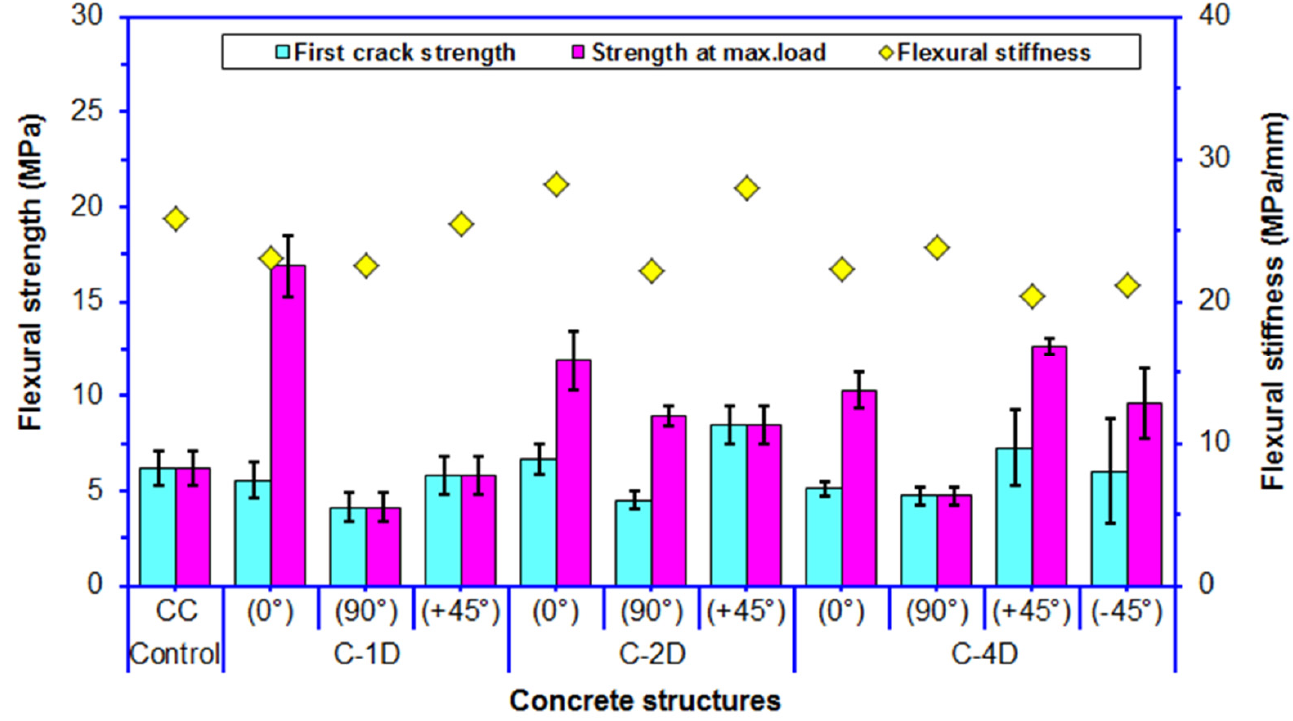
Figure 12. Off-axis flexural strength, first crack strength, and initial stiffness of various multiaxis 3D fiber concrete.